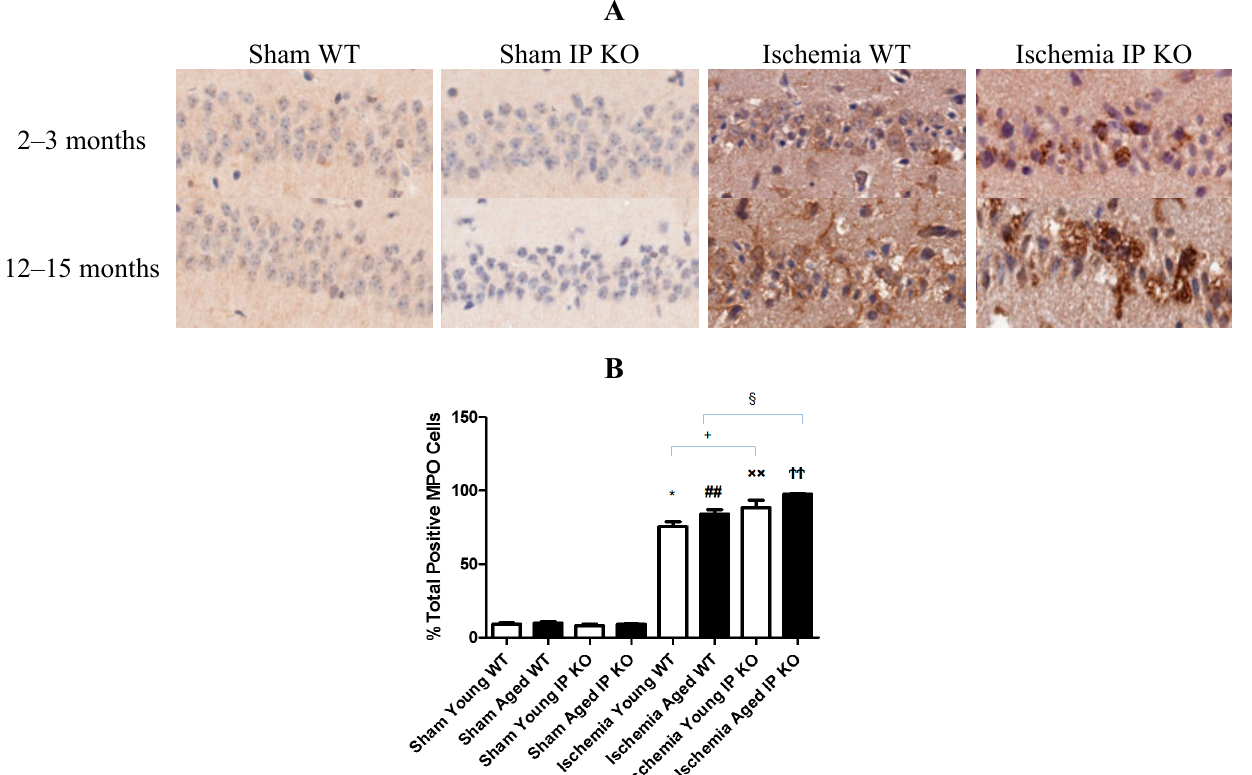
Figure 6. Myeloperoxidase activity in young and aged WT and IP KO ischemic mice after 12 min global cerebral ischemic insult. ( A ) Representative images of brain sections show MPO immunostaining. ( B ) Quantification of MPO positive cells in the hippocampal CA1 subfield on day 7 after ischemia. ( n = 3 per group). * p < 0.05, ## p < 0.01, ×× p < 0.01, ϮϮ p < 0.01 for Ischemia vs. Sham; + p < 0.05, § p < 0.05 for Ischemia IP KO vs. Ischemia